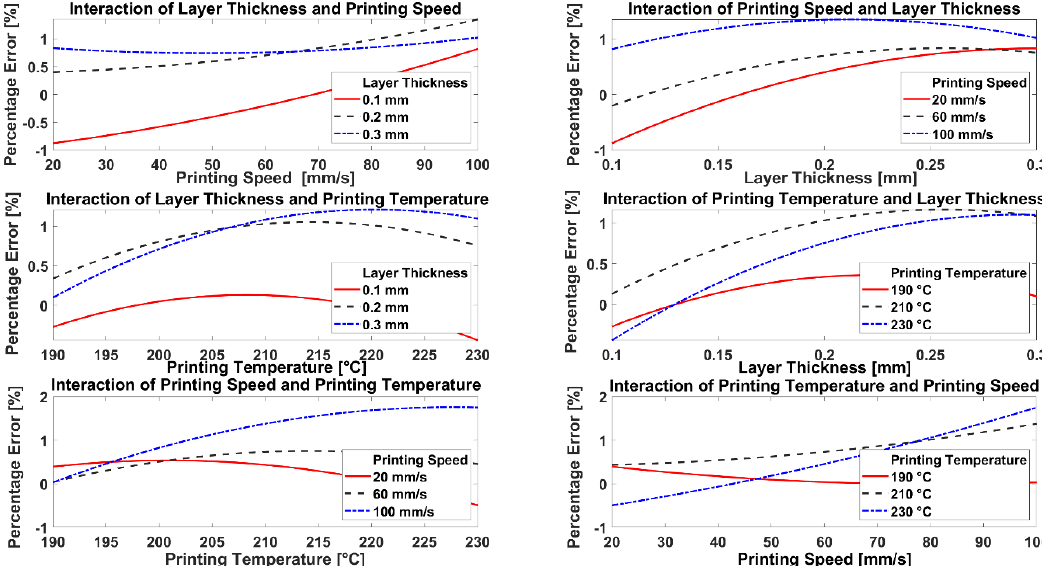
Figure 7. Effects of interaction of parameters on measured percentage error for 10 mm length in the X direction.